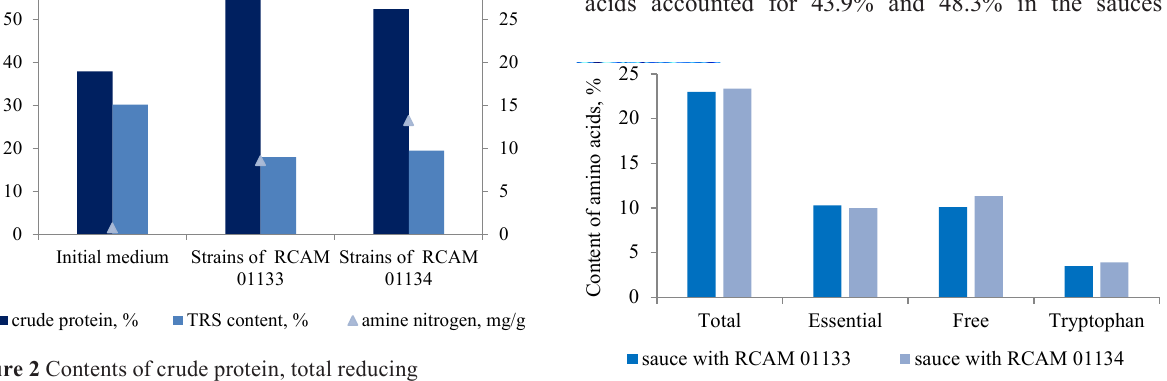
Figure 2 Contents of crude protein, total reducing sugars (TRS), and amine nitrogen in Aspergillus oryzae strains of RCAM 01133 and RCAM 01134 during solid-phase cultivation